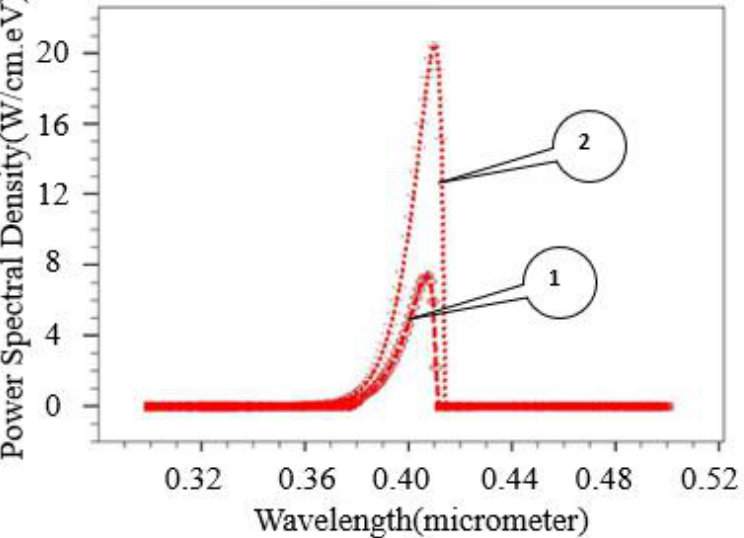
Figure 8. Wavelength vs. power spectral density of simulated SiC-based SQW LED. (Where curve-1 is at an anode voltage of 4 V and curve-2 is at an anode voltage of 6 V) for comparison that is purely based on SiC-SiC wafers considering the diffusion bonding ap- proach.